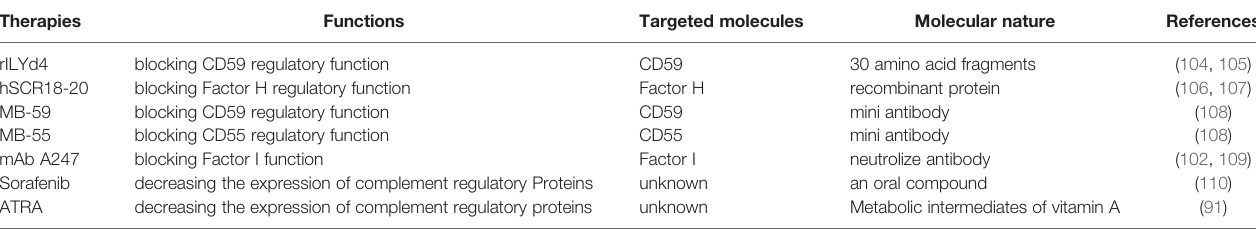
TABLE 1 | Complement-related therapies for treatment of hematological